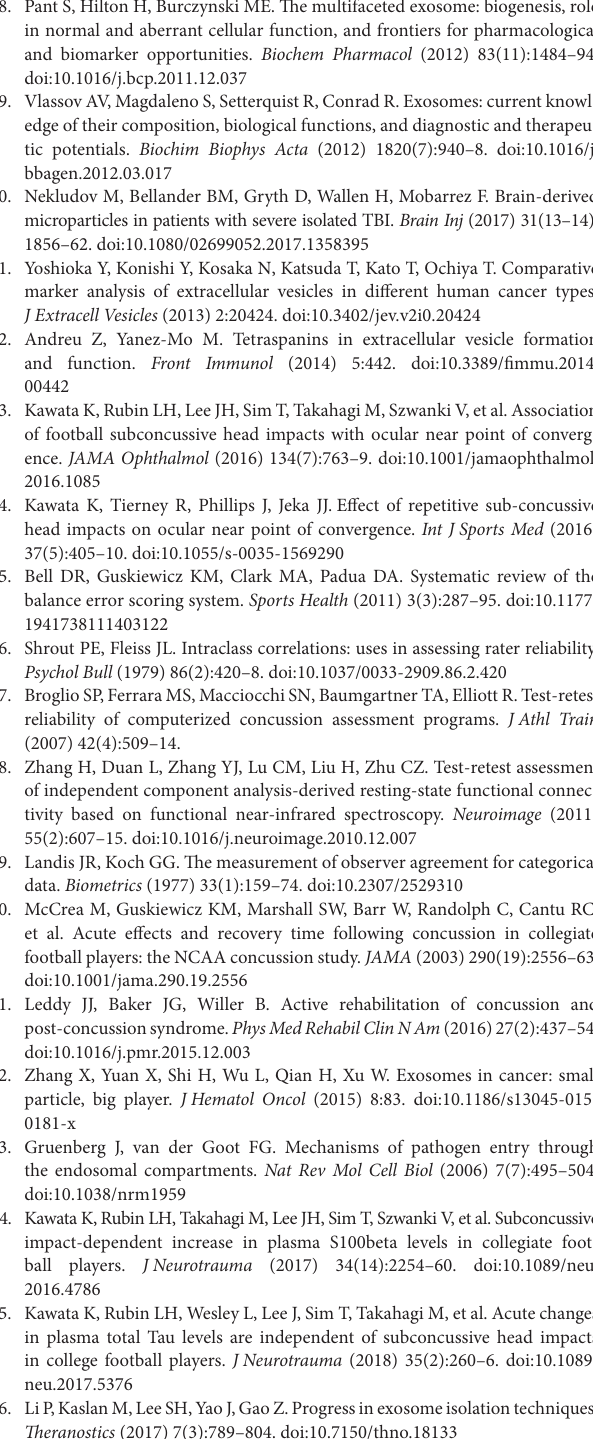
FigUre s3 | Fluctuation of plasma levels of glial markers. (a) [CD81] EAAT1 + (U/mL), (B) [GFAP] EAAT1 + (U/mL), (c) [GFAP] EAAT1 + /[CD81] EAAT1 + ratio, (D) [CD81] OMG + (U/mL), (e) [MBP] OMG + , (U/mL), (F) [MBP] OMG + /[CD81] OMG + ratio, and (g) [SYP] CD11b + /[CD81] CD11b + . Each symbol represents a